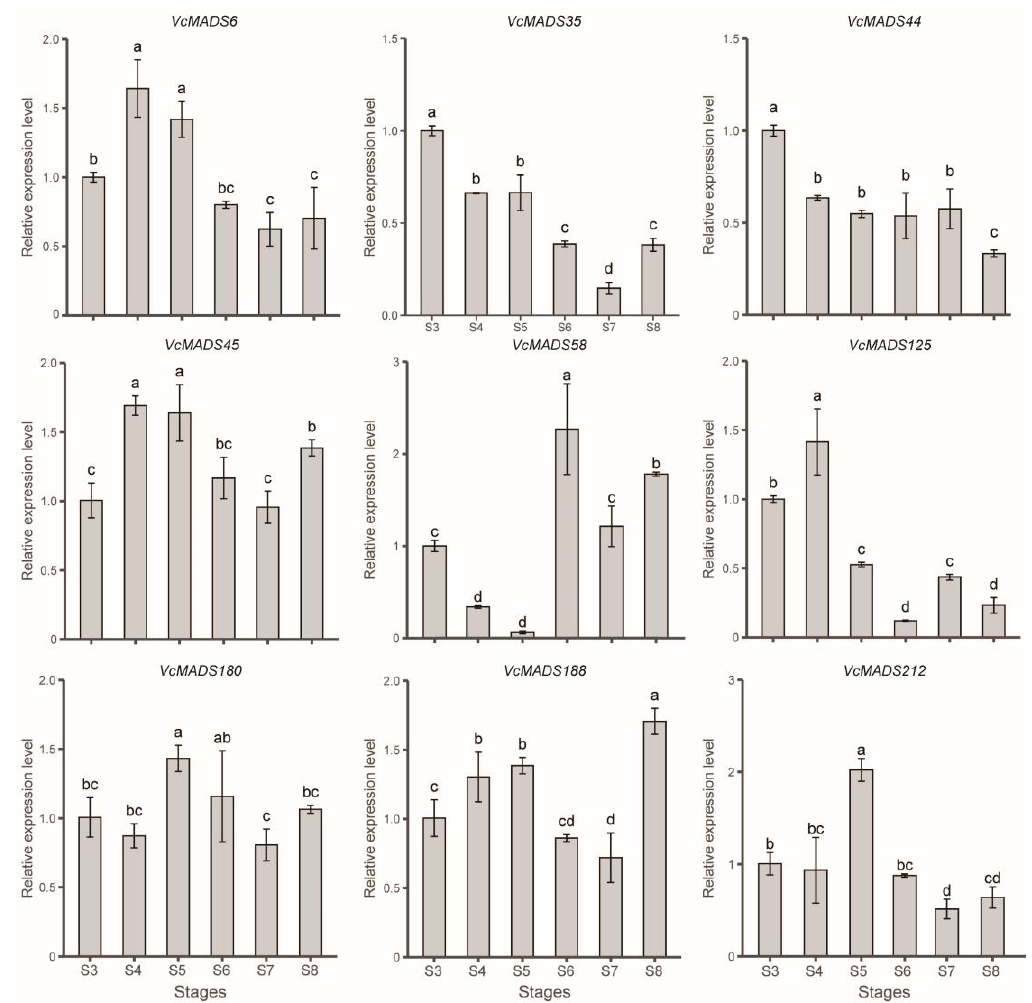
Figure 9. Relative expression of blueberry MADS-box genes in the fruit developmental stages. Lower- case letters represent significant differences. Different labeled letters for stages indicate significant differences in expression levels ( p < 0.05, LSD